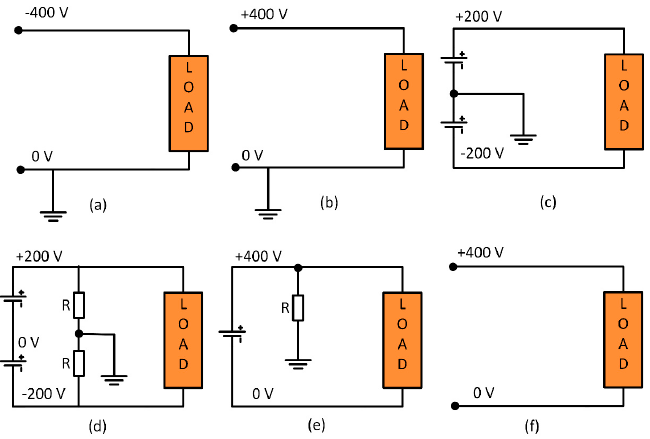
Figure 6. Grounding methods: ( a ) positive line; ( b ) negative line; ( c ) mid-point; ( d ) mid-point high resistance; ( e ) one-end high resistance; ( f ) floating system.